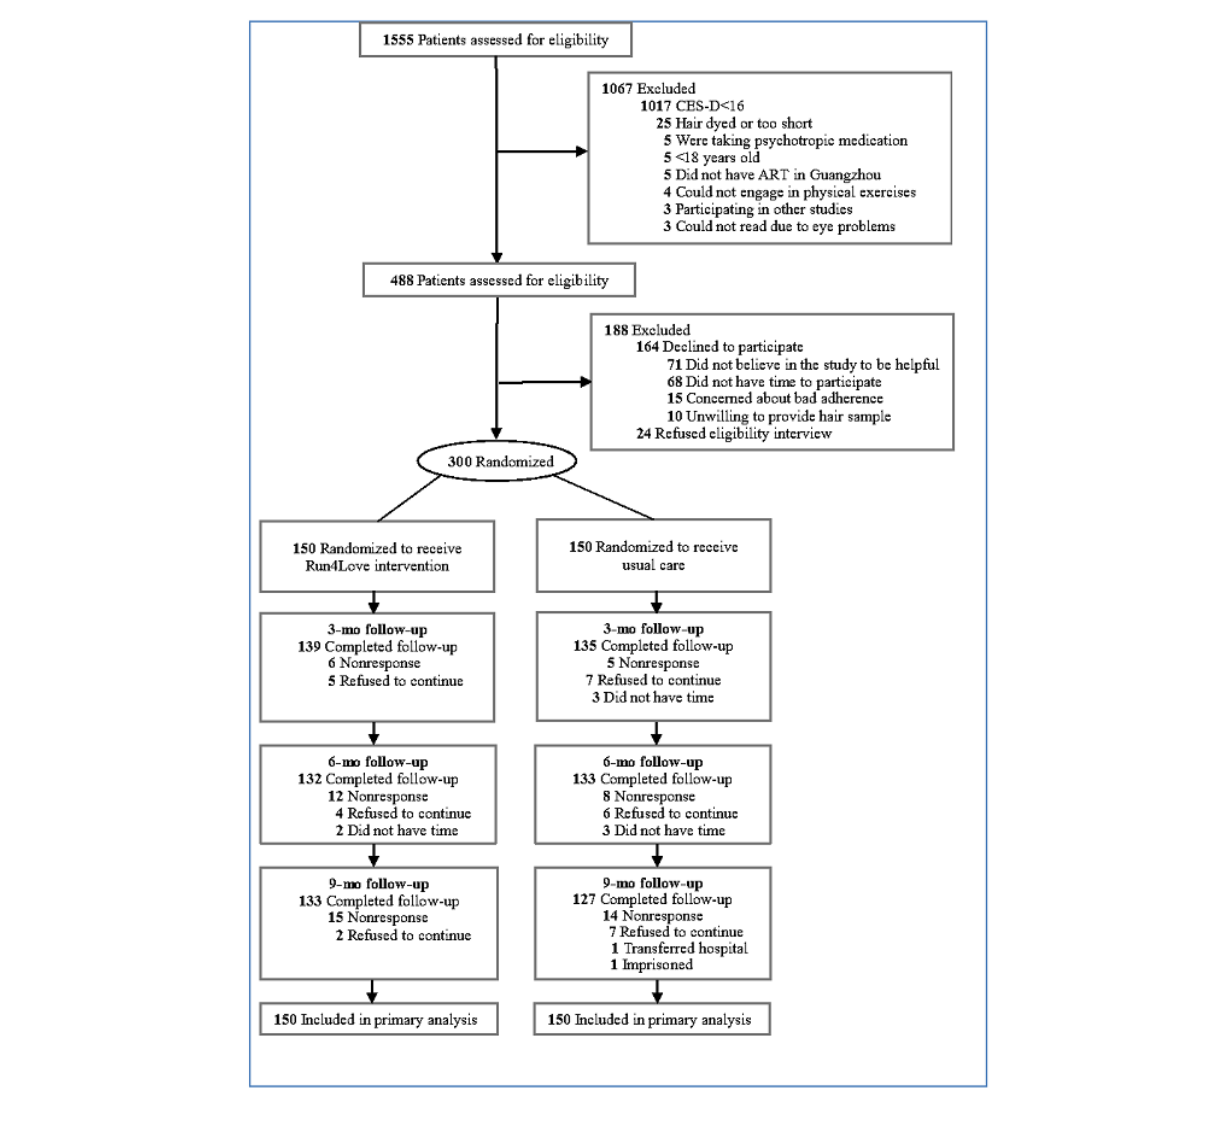
Figure 1. Flowchart of participant screening and